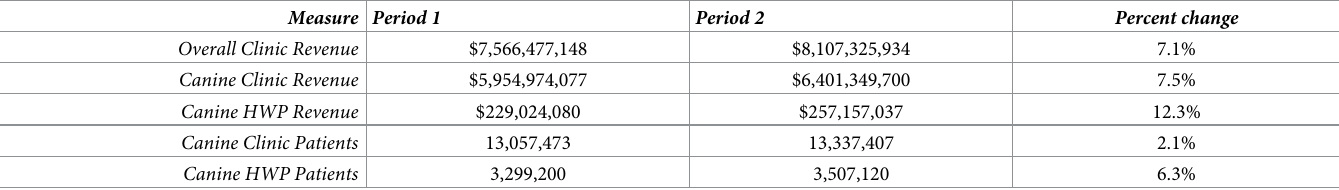
Table 1. Comparison of overall practice revenue, period 1 vs period